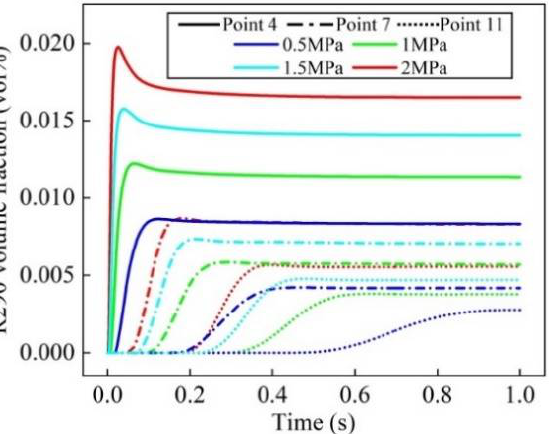
Figure 13. Variations in the R290 concentration in external space over time under different initial leakage pressures.